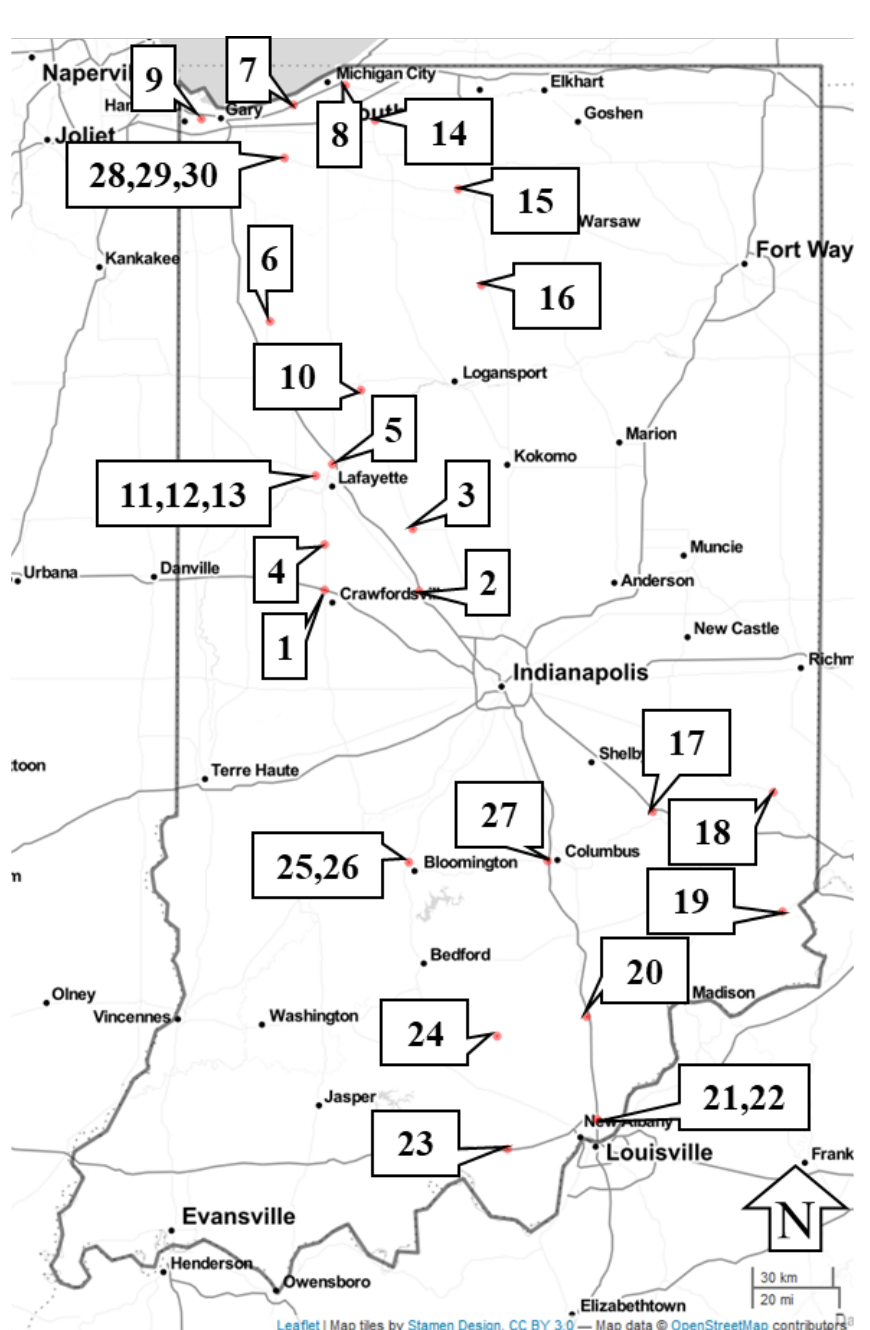
Figure 5. Locations of data collections across Indiana.